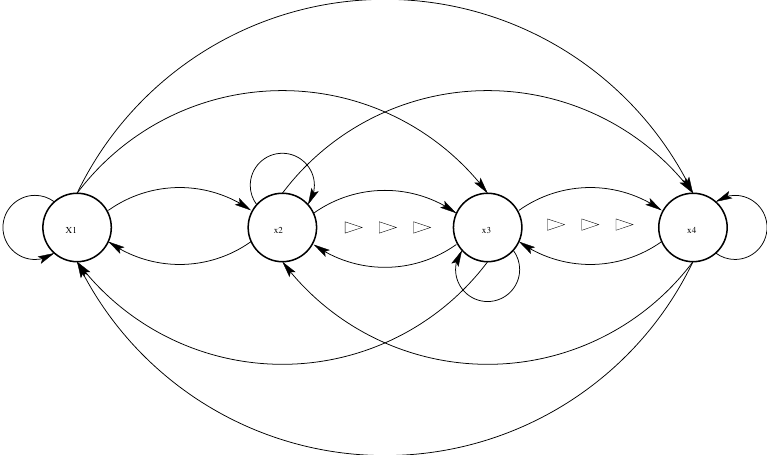
Figure 2. Neuron-connection architecture of the associated RNN model for designing the controller of chaotic sensor systems with x s i denoting the i th